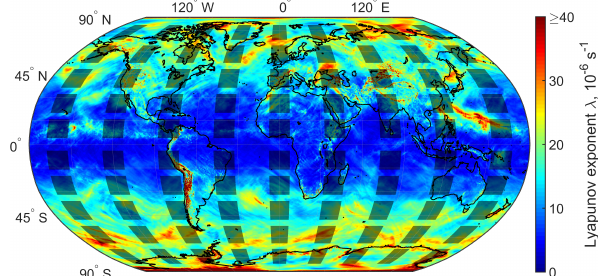
Figure 1. Plume initialization locations overlaid on the mean 2-D Lyapunov exponent λ for the 1–9 July 2015 period of the simula- tions. Initialization regions for each of the 90 plumes are shown as semitransparent black